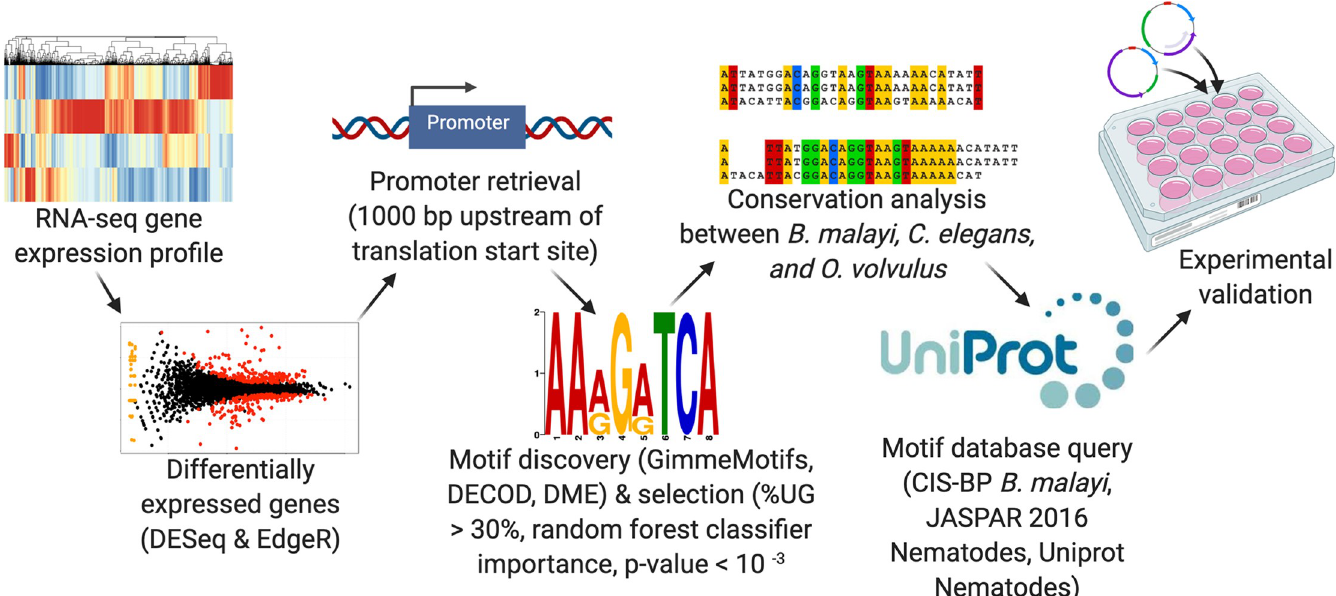
Fig 2. Workflow for promoter motif identification. The six main steps for motif discovery were: (1) generation of an RNA-seq profile; (2) determination of up- regulated genes for every pairwise comparison using DESeq2 (FDR < 0.01) and EdgeR (adjusted P-value < 0.01); (3) promoter retrieval: 1000 bp upstream of the translation start site; (4) ensemble motif discovery using GimmeMotifs (Homer, AMD, BioProspector, MDmodule, MEME, Weeder, GADEM, and Improbizer), DECOD, DME, and selection of enriched motifs: %UG > 30% and random forest classifier feature importance and over-representation p-value < 10 − 3 ; (5) TFBS conservation analysis between B . malayi , C . elegans , and O . volvulus ; and (6) motif database query: CIS-BP B . malayi , JASPAR 2016 Nematodes, Uniprot Nematodes. Finally, a subset of those identified motifs were experimentally validated.